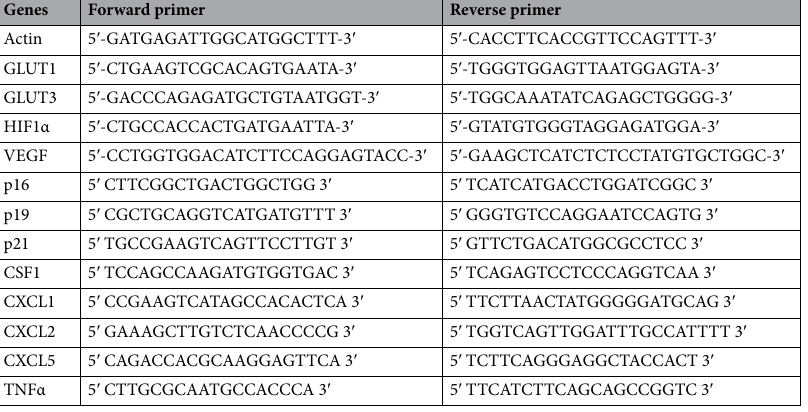
Table 1. Sequence of primers used for